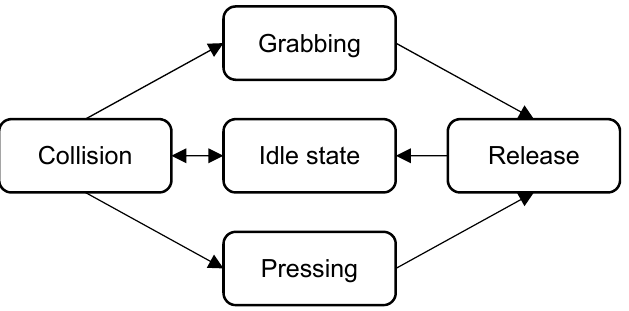
Figure 1. The interaction state workflow of the VR intubation training. Table 1. Differences of interaction commands between controller and hand tracking.